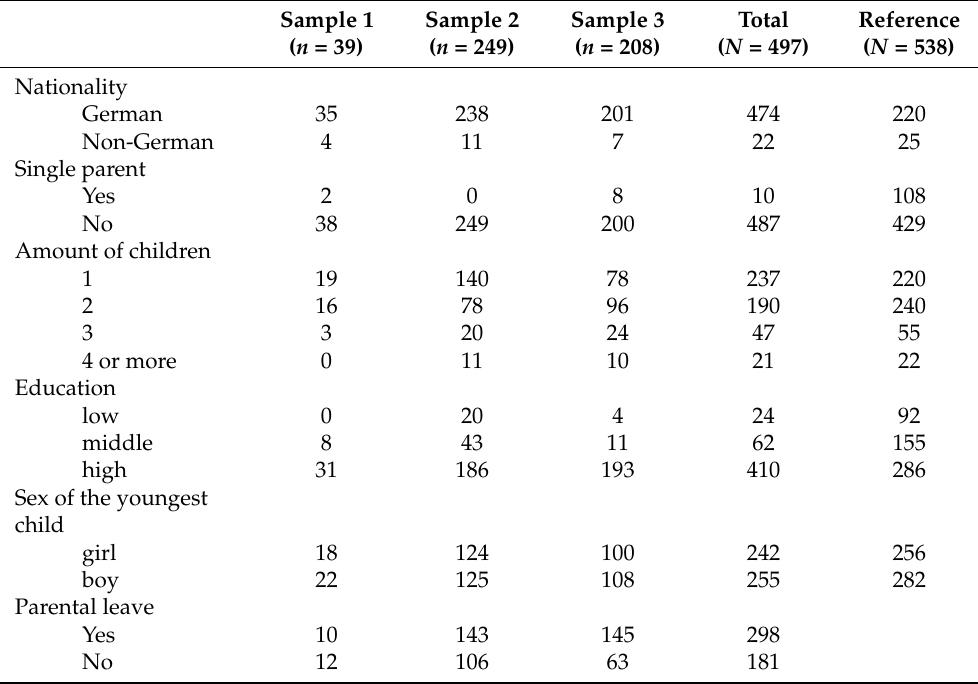
Table 1. Overview of the three samples and their sociodemographic